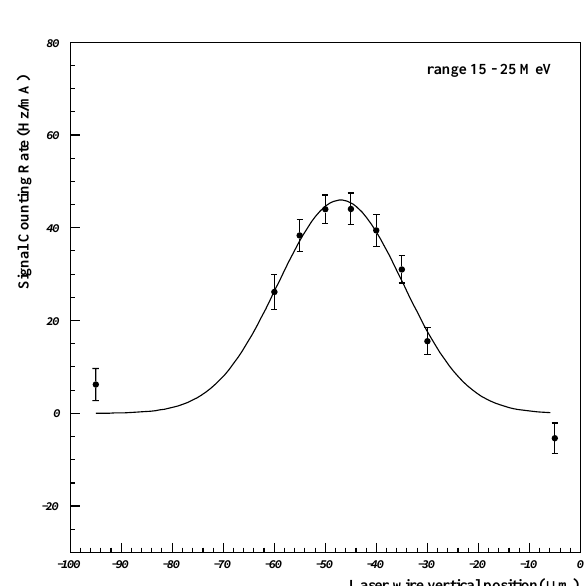
FIG. 5. The signal count rates for energies of 15–25 MeV as a function of the laser wire vertical position. The solid line is the simple Gausssian fit to the data (see the text for detail).